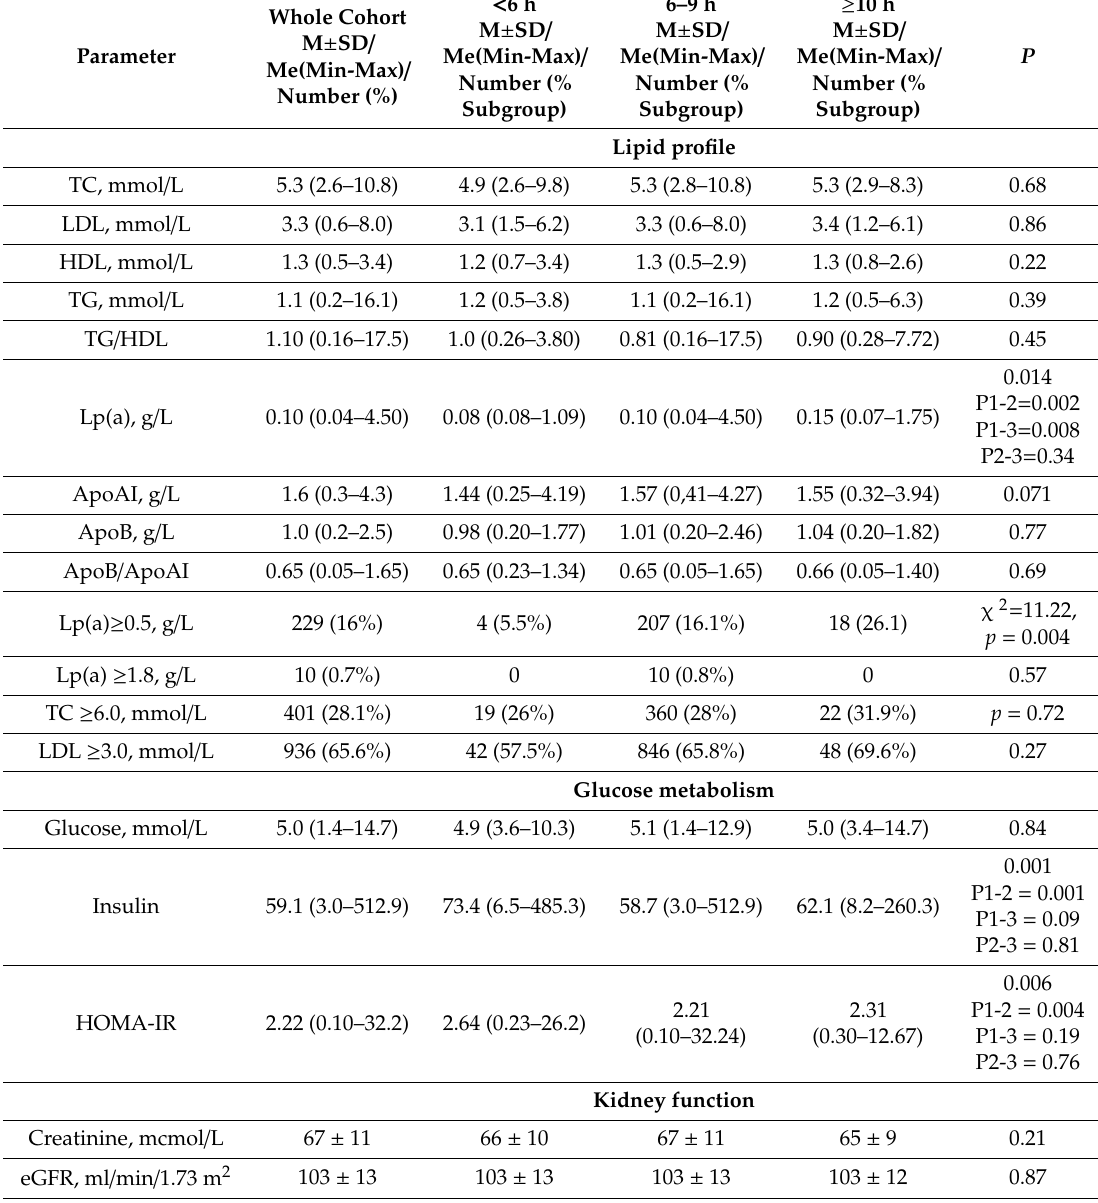
Table 3. Laboratory parameters in the groups depending on sleep duration. HOMA-IR: homeostatic model assessment for insulin resistance, Lp(a): lipoprotein (a), TC: total cholesterol, LDL: low-density lipoproteins, HDL: high-density lipoproteins, TG: triglycerides, ApoAI: apolipoprotein AI, and ApoB: apolipoprotein